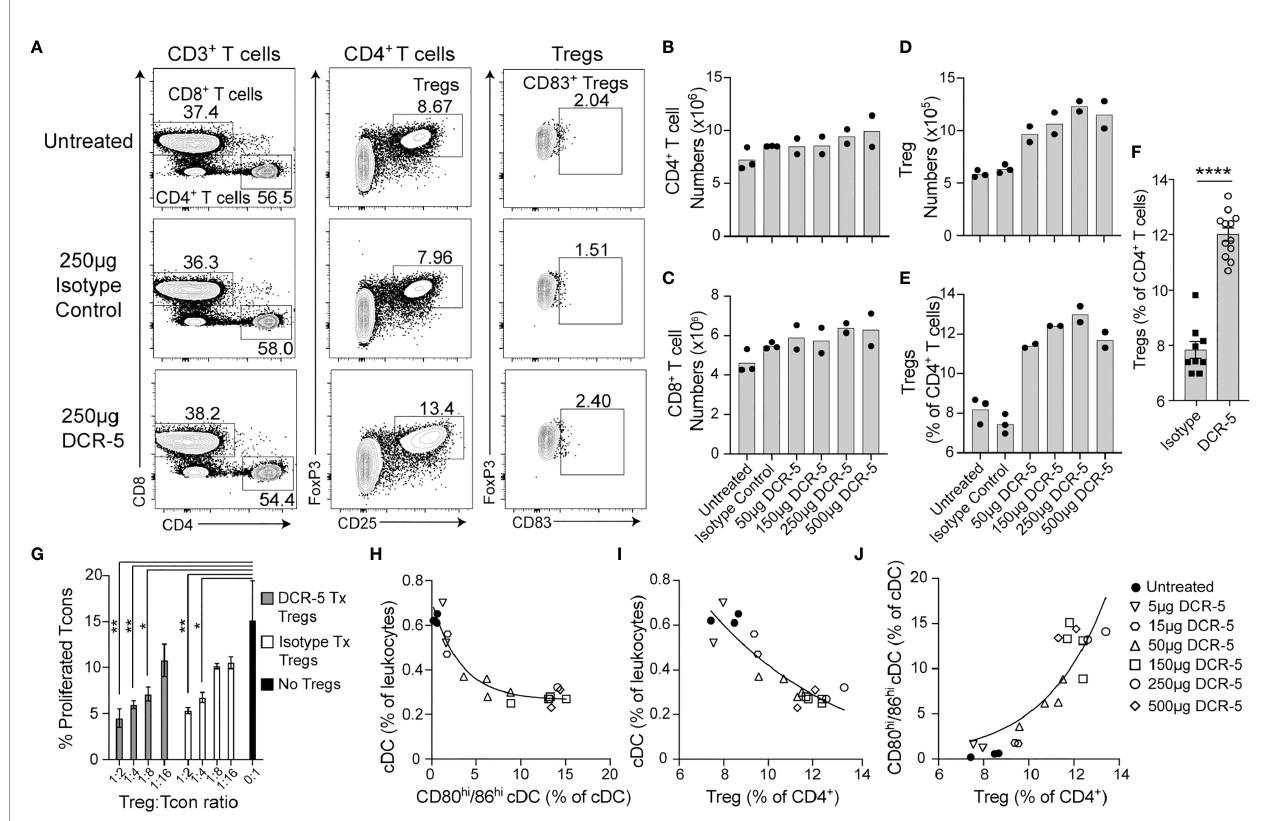
FIGURE 6 | In vivo treatment of mice with DCR-5 results in induction of Treg. B6 mice treated with a single i.p. injection of increasing doses of DCR-5 mAb or 250 µg rat IgG2a isotype control were analysed 48 h later for T cell subsets by fl ow cytometry. (A) Flow cytometry plots in one experiment showing T cell populations in spleens of untreated, 250 µg DCR-5 and isotype control mice. Total numbers of splenic (B) CD4 + T cells, (C) CD8 + T cells and (D) Tregs and (E) Treg as a percentage of CD4 + T cells in mice treated with increasing DCR-5 doses. No signi fi cant difference for CD4 or CD8 T cell numbers and p <0.0001 for Tregs numbers and proportion in combined DCR- 5 versus isotype treated or untreated mice (one-way ANOVA). (F) Combined data from fi ve experiments showing increase in Treg (as percentage of CD4 + T cells) in mice treated with 150 – 250 µg DCR-5 or isotype control. Statistical comparison was determined using a T-test. ****p < 0.0001. (G) Treg suppression assay showing proliferation of CFSE labeled CD45.1 + CD4 + Tcon puri fi ed from B6. Ptprc a mouse spleens cocultured with anti-CD3/28 beads and the indicated ratios of CD4 + CD25 + Tregs isolated from spleens of B6 mice after 48h treatment with 150 µg DCR-5 or isotype control i.p. All groups (n = 3) compared to Tcon only group by one-way ANOVA. *p < 0.05 and **p < 0.01. Correlation of (H) total cDC vs. CD80 hi /86 hi cDC, (I) total cDC vs. Treg and (J) CD80 hi /86 hi cDC vs. Treg frequencies in spleens of DCR-5 treated mice. All correlations were p < 0.0001 (Pearson correlation coef fi cient). Non-linear regression exponential curve fi ts